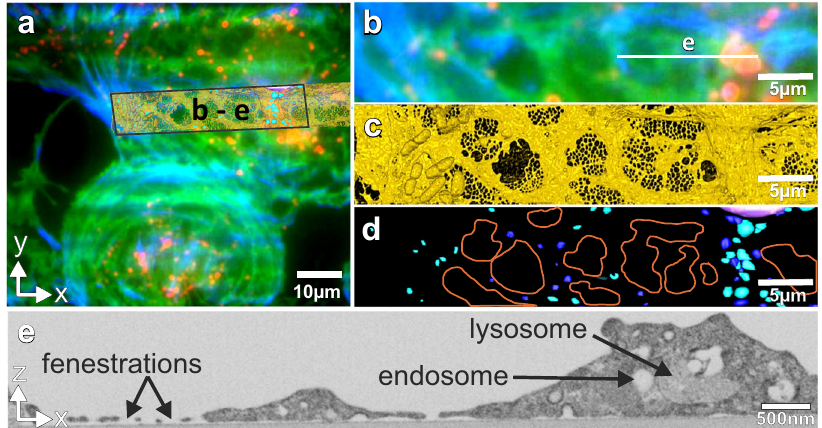
Fig. 4 Chip-based TIRF imaging combined with FIB-SEM of LSECs, sample 2. a , b Three channel chip-based TIRF, labeling actin (Phalloidin, in blue), cell membrane (CellMask, in green) and FSA after 2 h endocytosis (AF647-FSA, in red). c 3D reconstruction of FIB-SEM datastack viewed from the x / y plane showing fenestrations, d 3D projected overlay of SEM reconstruction showing endosomes (manually segmented in dark blue) and lysosomes (manually segmented in light blue), as well as graphical representation of the sieve plates (orange line). e FIB-SEM cross-section, x / z plane from Supplementary Video 1, corresponding to the red line in b . Correlation between ( b ) and ( d ) indicate that the endocytosed FSA is speci fi cally located in the